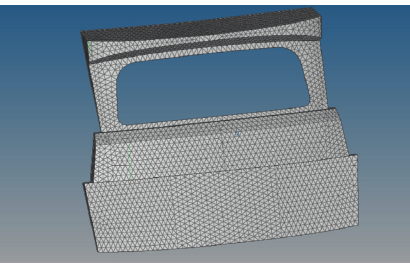
Figure 2: Meshing diagram. Table 1: Meshing results.